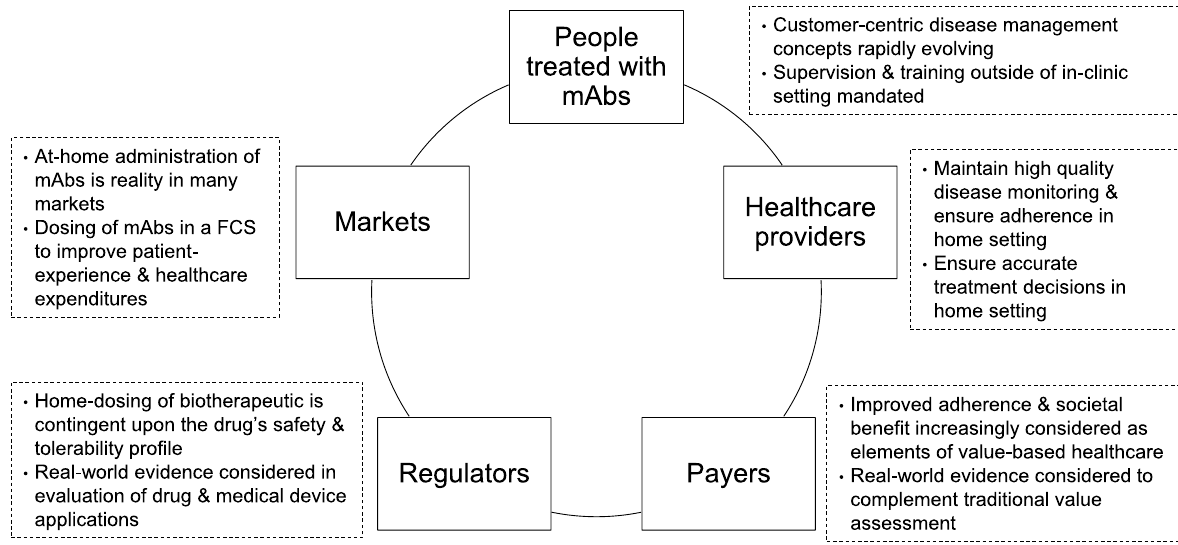
Fig. 1 Key healthcare trends that inform customer-centric drug delivery needs for monoclonal antibodies. Need for technologies that enable dosing and data collection in a flexible care setting